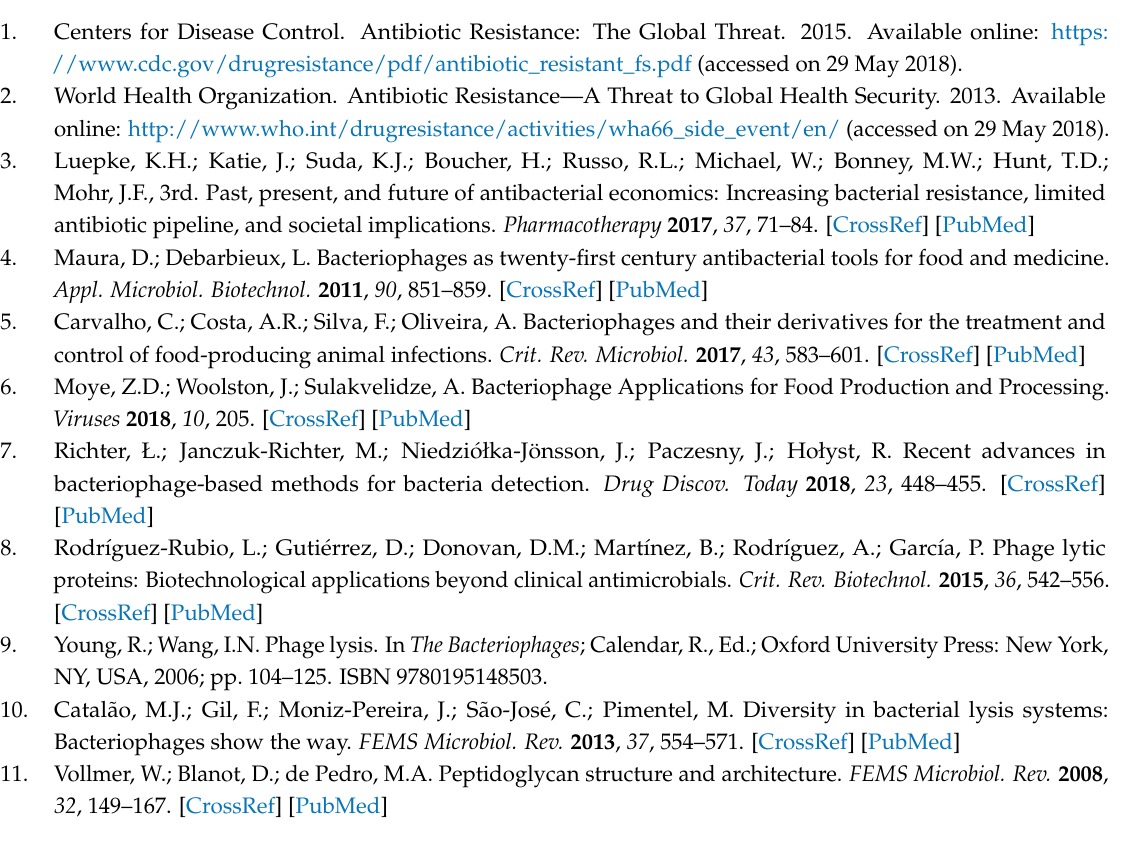
Table S1: Coordinates of LysB; Figure S1: Schematic representation of the endolysins targets in the bacterial peptidoglycan, Figure S2: Alignment of LysB